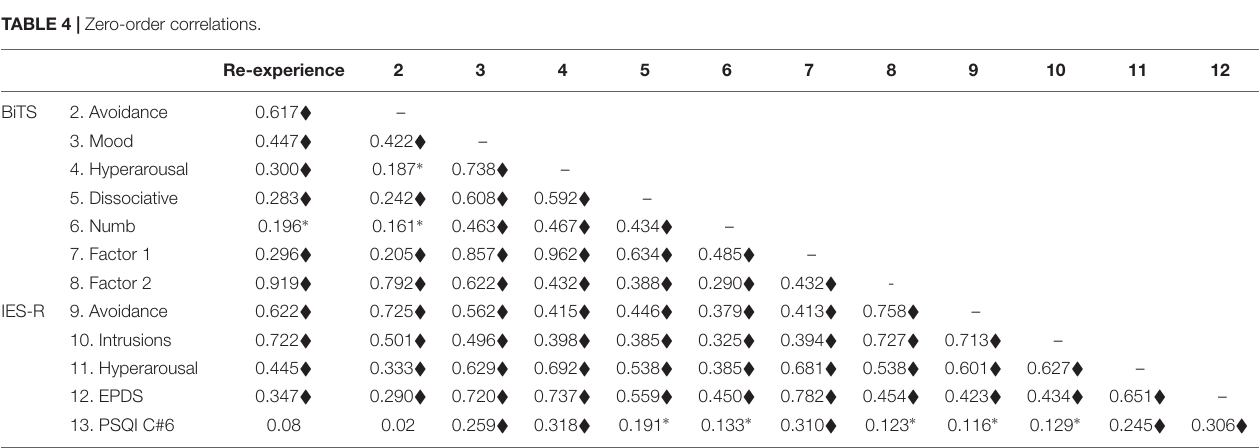
FIGURE 1 | Univariate ANOVA analyses on the total symptoms subscale of the BiTS and the two Factors derived from the factor analysis. (A–C) Comparison of the effects of type of delivery on symptom severity. There was a main effect of delivery type on the total symptom subscale and on Factor 2, due to significantly higher scores among women who underwent emergency cesarean. (D) Effects of pregnancy risk on Factor 1. ∗∗ p < 0.001. TABLE 4 | Zero-order